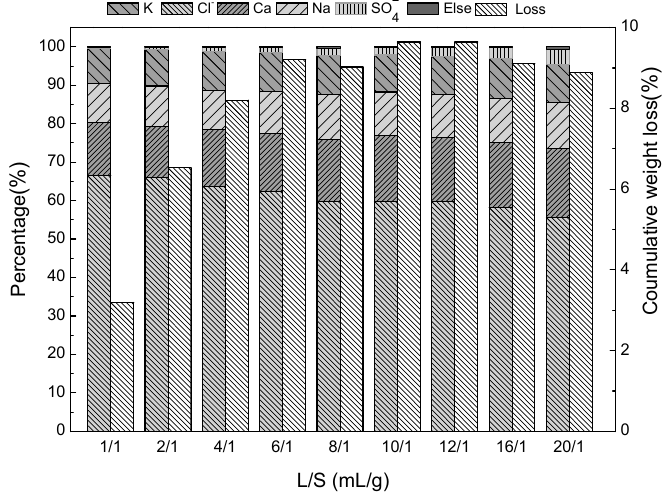
Figure 1. The distribution of components in the leachate and cumulative weight loss of air pollution control (APC) residue.